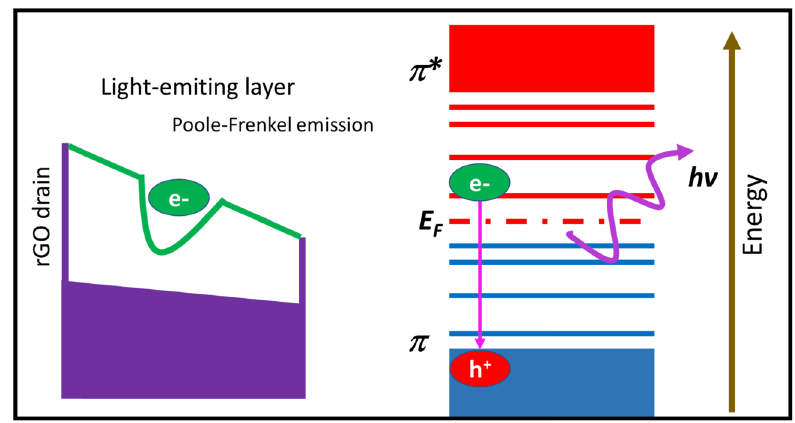
Figure 25: Scheme for the charge injection process of GFLED.